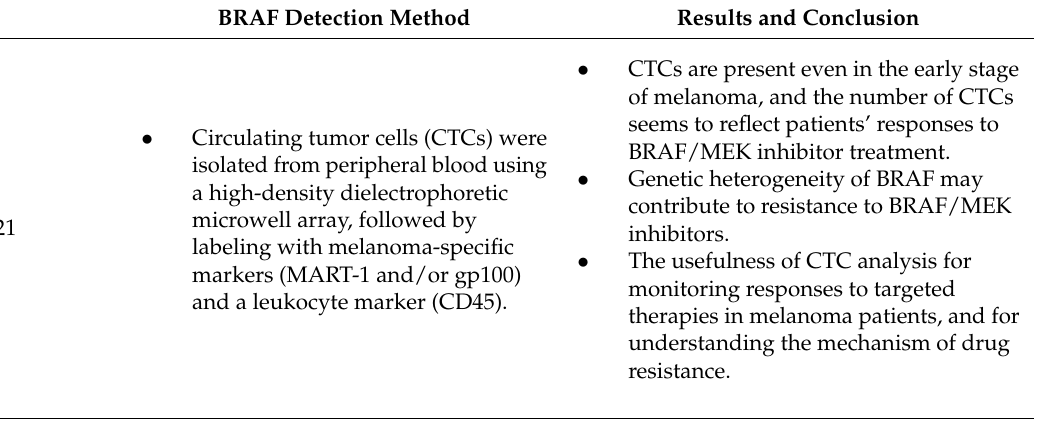
Table 2. Modern methods for BRAF